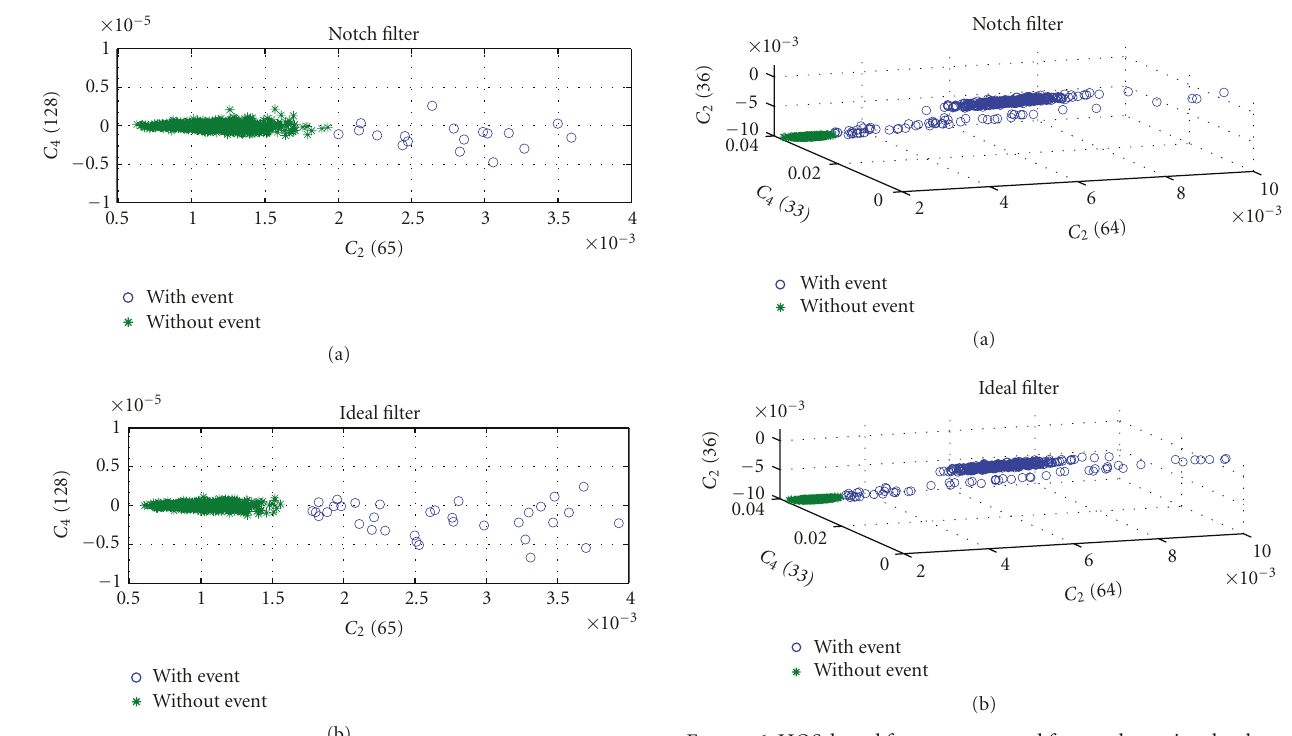
Figure 5: HOS-based features extracted from voltage signals whose frame length is equal to N = 64. While second-order statistics are extracted from f , the fourth-order statistic is extracted from u .